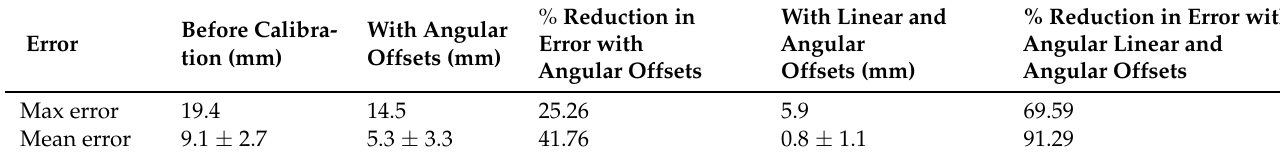
Table 4. Resultant position error before and after calibration.